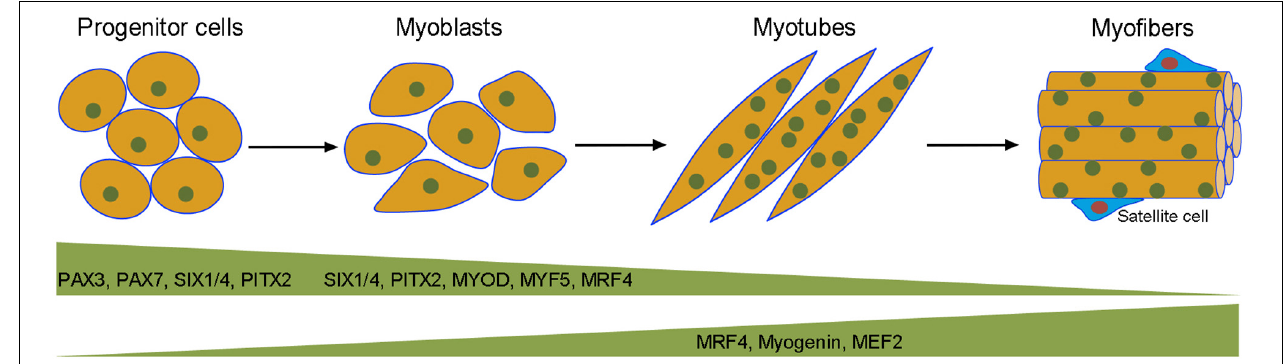
FIGURE 1 | Transcriptional regulation of embryonic myogenesis. Muscle progenitor cells in the somites are committed to the myogenic lineage by the action of PAX3, PAX7, SIX1/4, and PITX2. Mononucleated myoblasts proliferate and differentiate into multinucleated myotubes under the sequential regulation of myogenic transcription factors at different steps of myogenesis. Quiescent satellite cells or muscle stem cells are located between the sarcolemma (plasma membrane) of myofibers and the basal lamina. These cells contribute to muscle regeneration by re-activating the myogenic